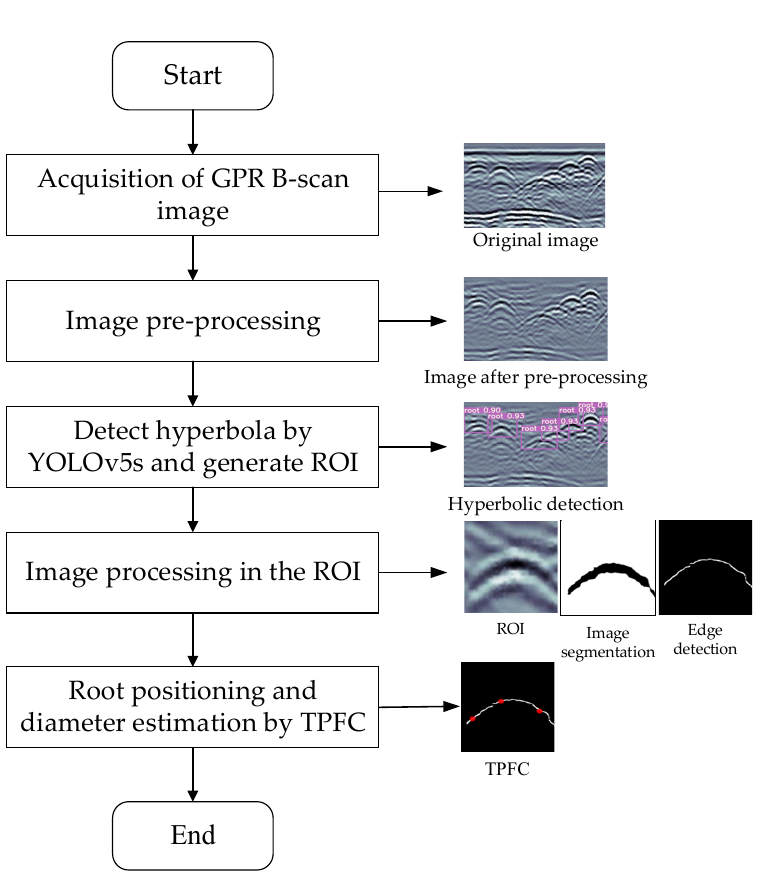
Figure 10. Implementation process of the method.